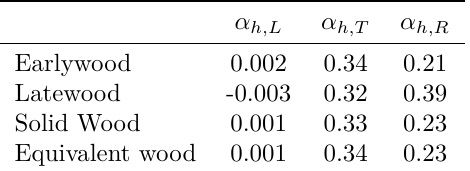
Table 4. Effective coefficients of hygroexpansion of wood from numerical homogenization (MFA=15 ◦